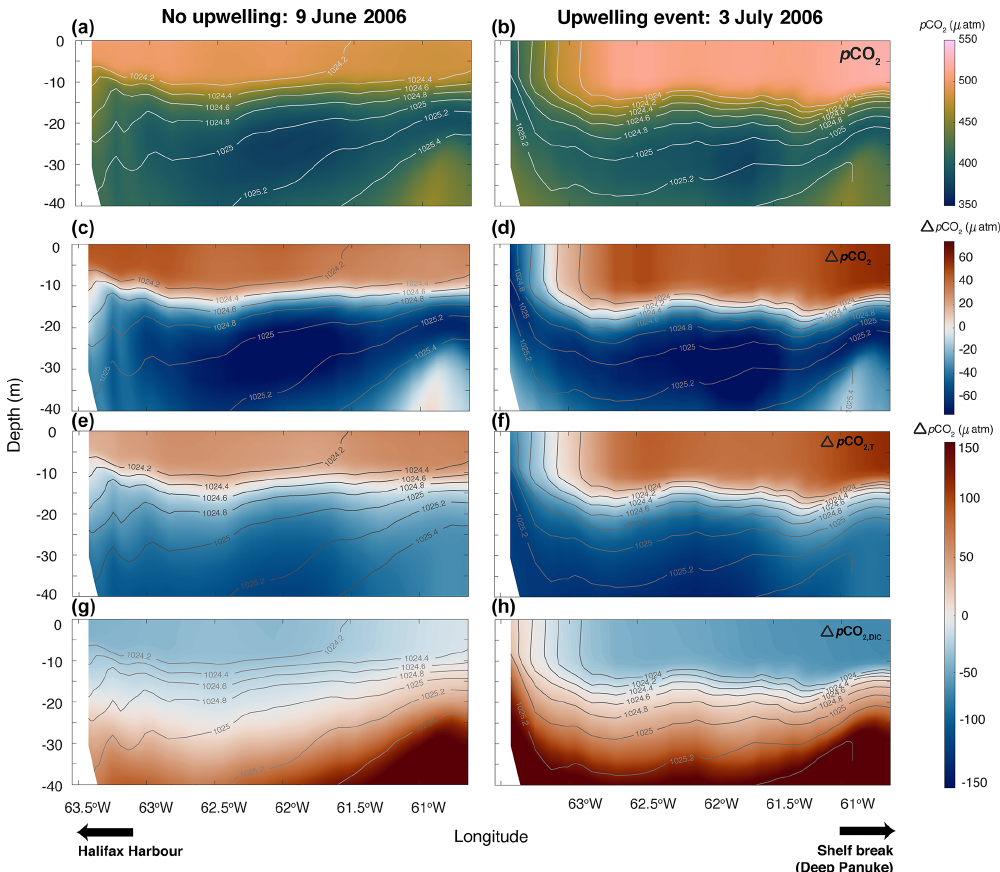
Figure 7. Taylor decomposition of the upwelling event (right side; 3 July 2006) in Fig. 6 compared to a non-upwelling event (left side; 9 June 2006). From top to bottom: (a, b) p CO 2 , (c, d) overall anomaly in p CO 2 ( (cid:49)p CO 2 ) from the mean p CO 2 in the upper 40m, (e, f) anomaly in p CO 2 due to temperature changes ( (cid:49)p CO 2 ,T ), and (g, h) anomaly in p CO 2 due to DIC changes ( (cid:49)p CO 2 , DIC ).